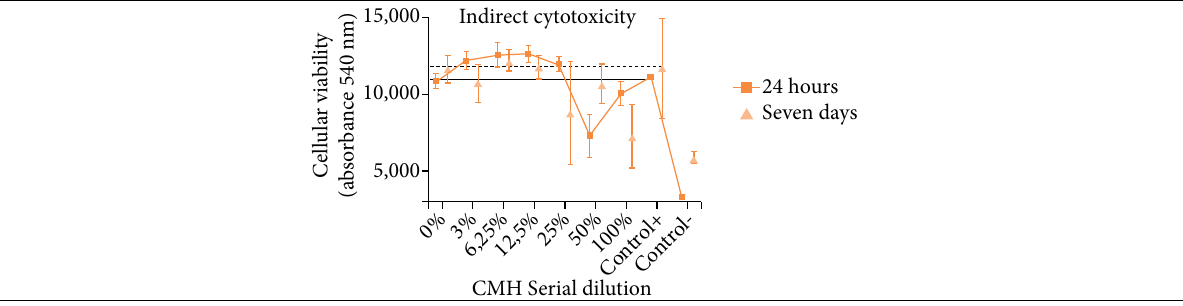
Figure 9 - Indirect cytotoxicity with culture medium with hydrogel (CMH) and fibroblasts. The assay was made with a conditioned CMH. CMH was conditioned for two different periods of time: 24 hours and seven days. The serial dilution refers to the percentage of CMH used during cell incubation – 100%: 100- μ L CMH; 50%: 50- μ L MCH + 50- μ L Dulbecco’s modified eagle medium (DMEM); 25%: 25- μ L + 75- μ L DMEM; 12,5%: 12,5- μ L CMH + 87,5- μ L DMEM; 6,25%: 6,25- μ L MHC + 93,75- μ L